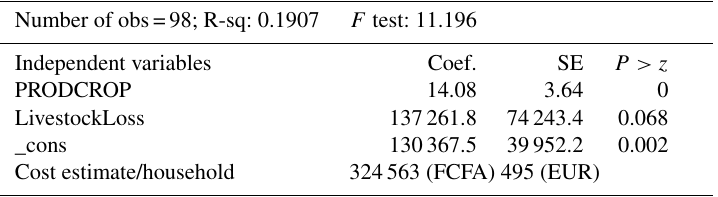
Table 12. Costs of droughts – multivariate linear regression